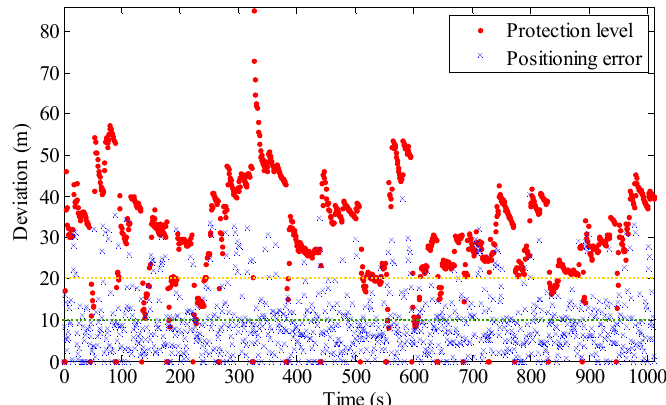
Figure 13. Simulated positioning error and protection level.